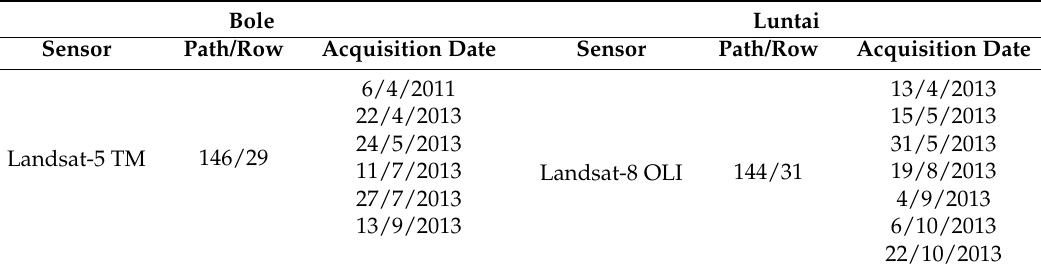
Table 11. Landsat data using in the classification of crops in Luntai and Bole.